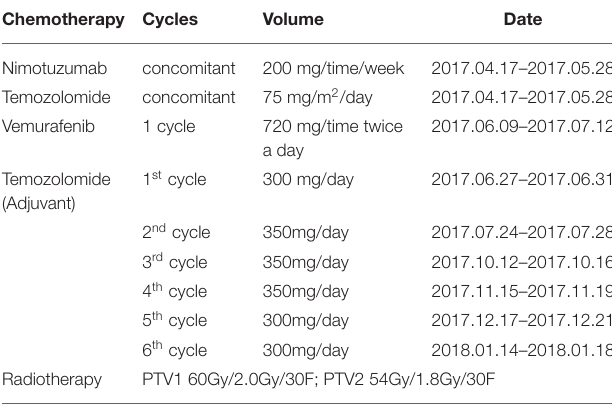
TABLE 2 | Postoperative Chemo-radiotherapy Strategy. Chemotherapy Cycles